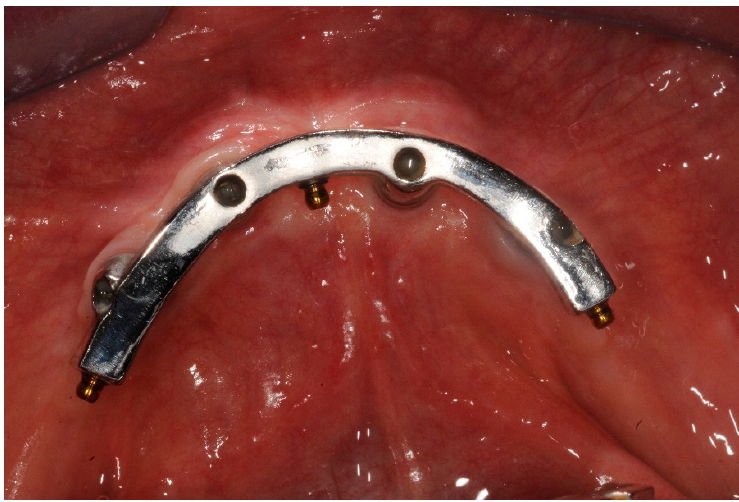
Figure 1. Melted implant-bar, occlusal view at three years follow up.